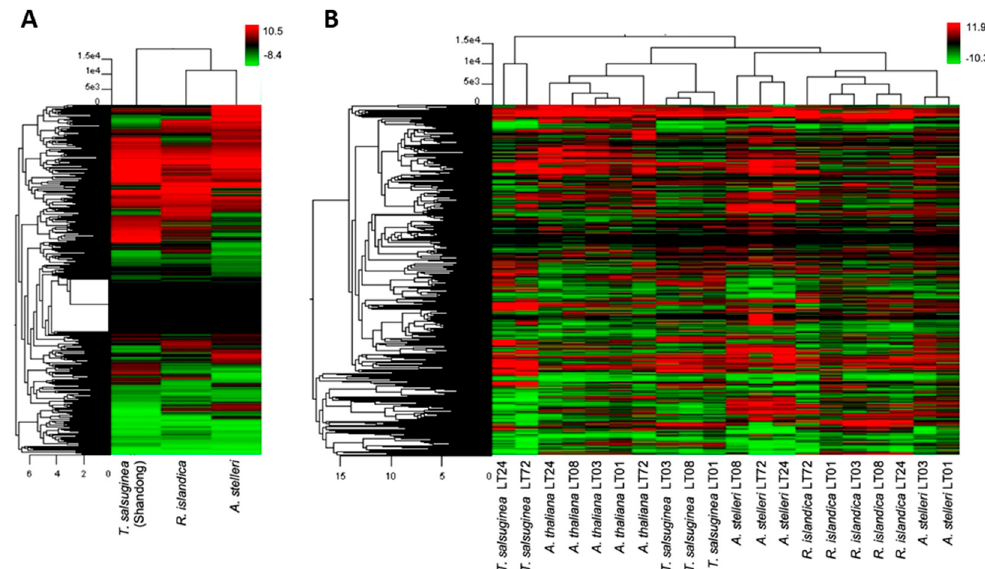
Figure 2. Hierarchical cluster of gene expression patterns in the four species. Gene expression patterns of A. thaliana , R. islandica , A. stelleri , and T. salsuginea ( Shandong ) under normal conditions ( A ) or low-oxygen stress ( B ) were clustered by Euclidean distance. Logarithmic scales indicating the color assigned to each fold change are shown to the right of cluster. LT: low-oxygen treatment.